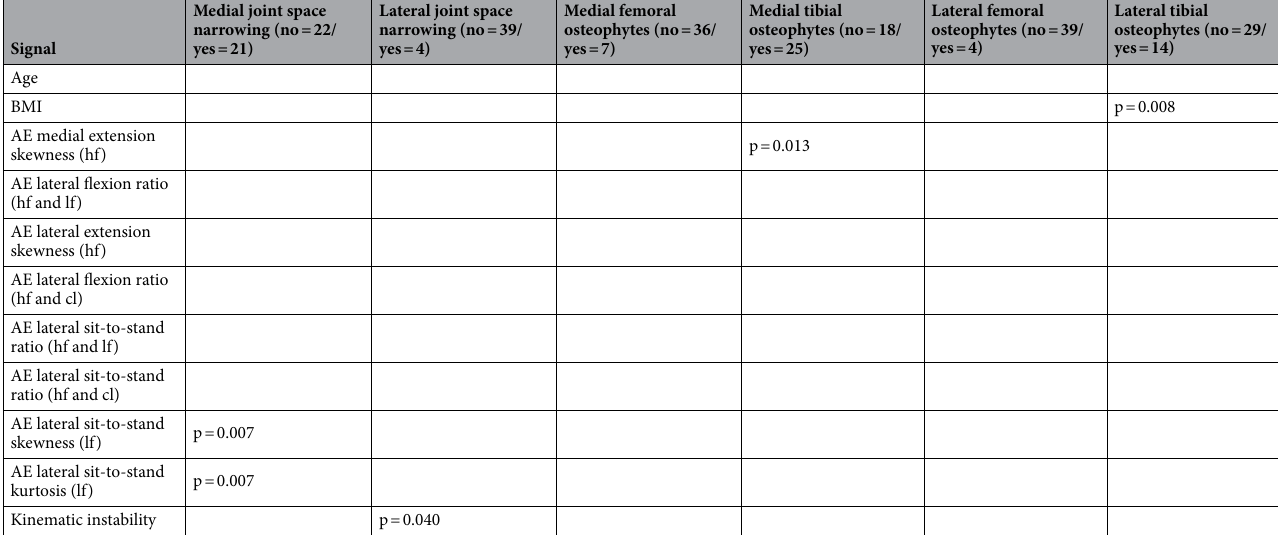
Table 4. The ability of acoustic emissions and kinematic instability (AUC > 0.600) to detect specific osteoarthritic changes in males. The absence or presence of osteoarthritic changes on conventional radiography are given in parentheses (no/yes), and corresponding statistically significant p-values for each biomarker. AE acoustic emission, BMI body mass index, hf high frequency, lf low frequency, cl clicks, all high and low frequency.